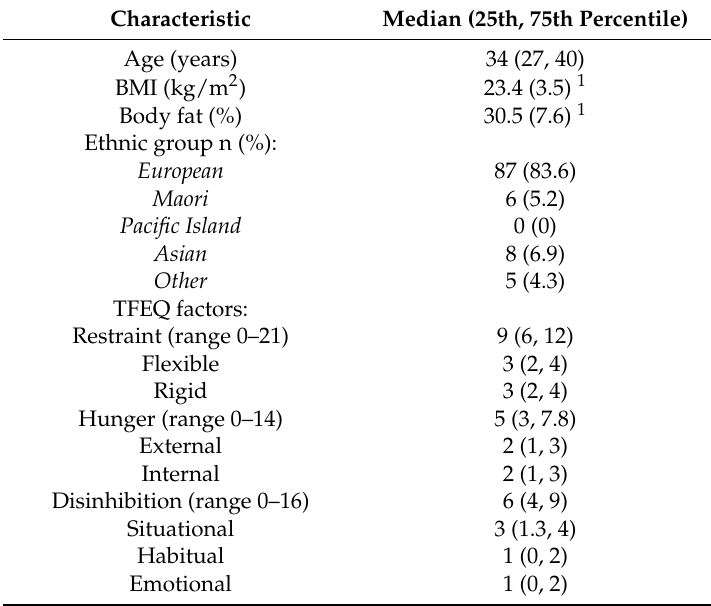
Table 1. Participant